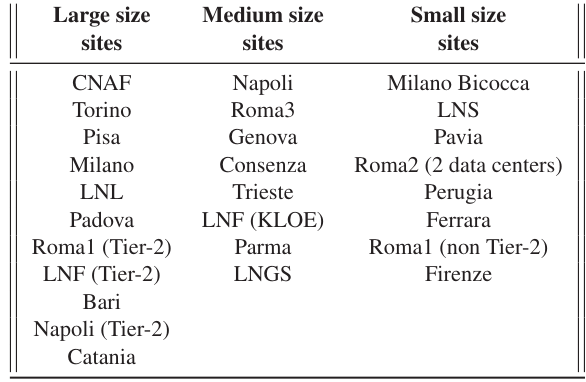
Figure 1. Cores vs Disk distribution at INFN.